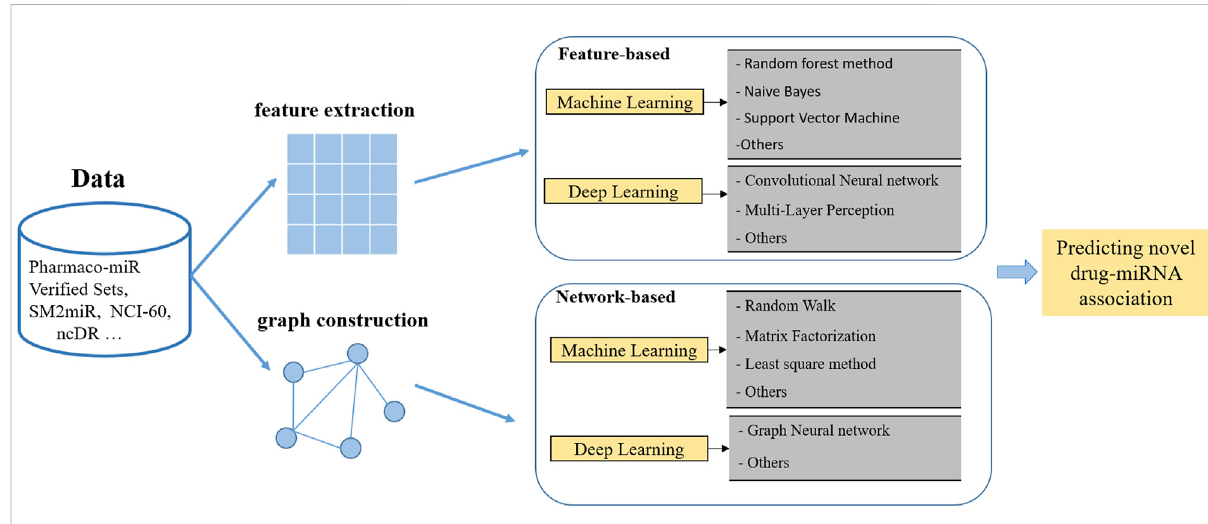
FIGURE 2 The process of computational models for identifying miRNA-drug